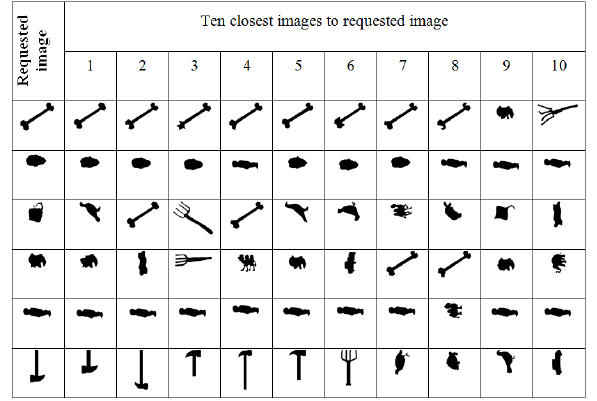
Figure 13: Top closest shapes for the requested shape. Orienta- tion spectrum was used.